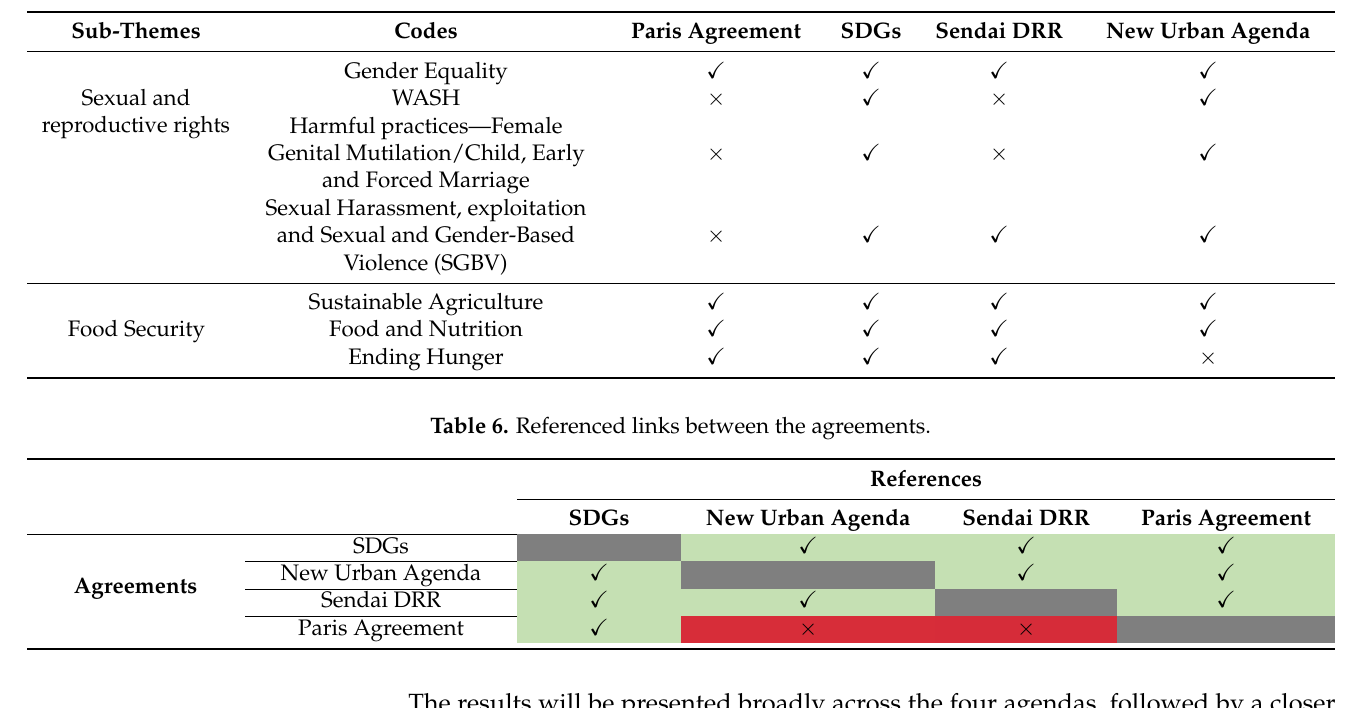
Table 5. Analysis of sexual and reproductive rights and food security sub-themes across all four policies. Sub-Themes